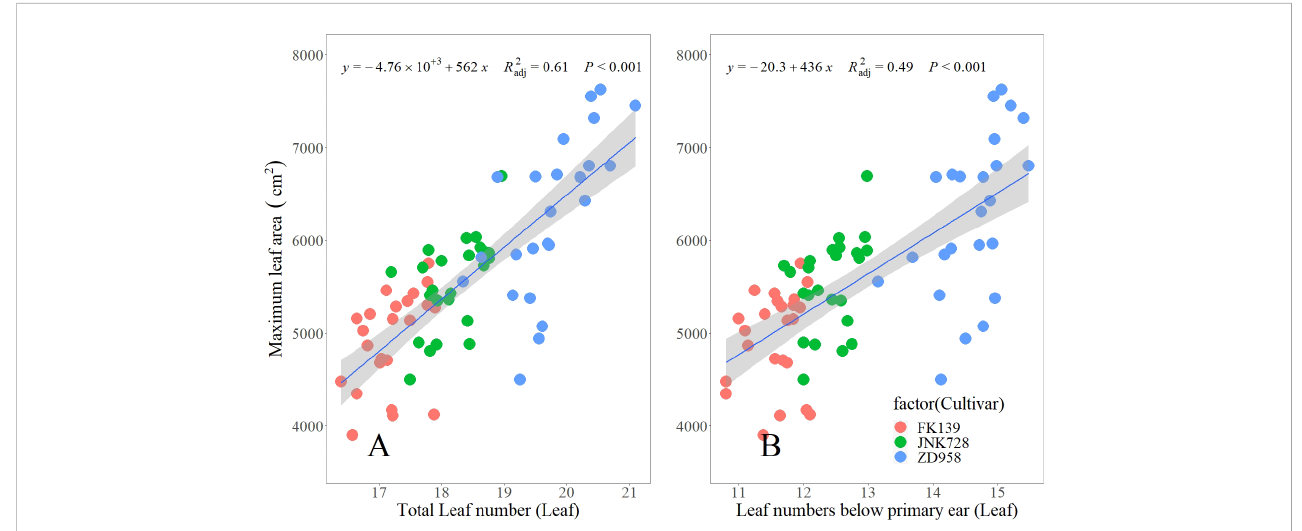
FIGURE 4 Relationship between leaf number variables and maximum leaf area at the silking stage. ( A, B represent the relationship between the maximum leaf area and TLN, LB,